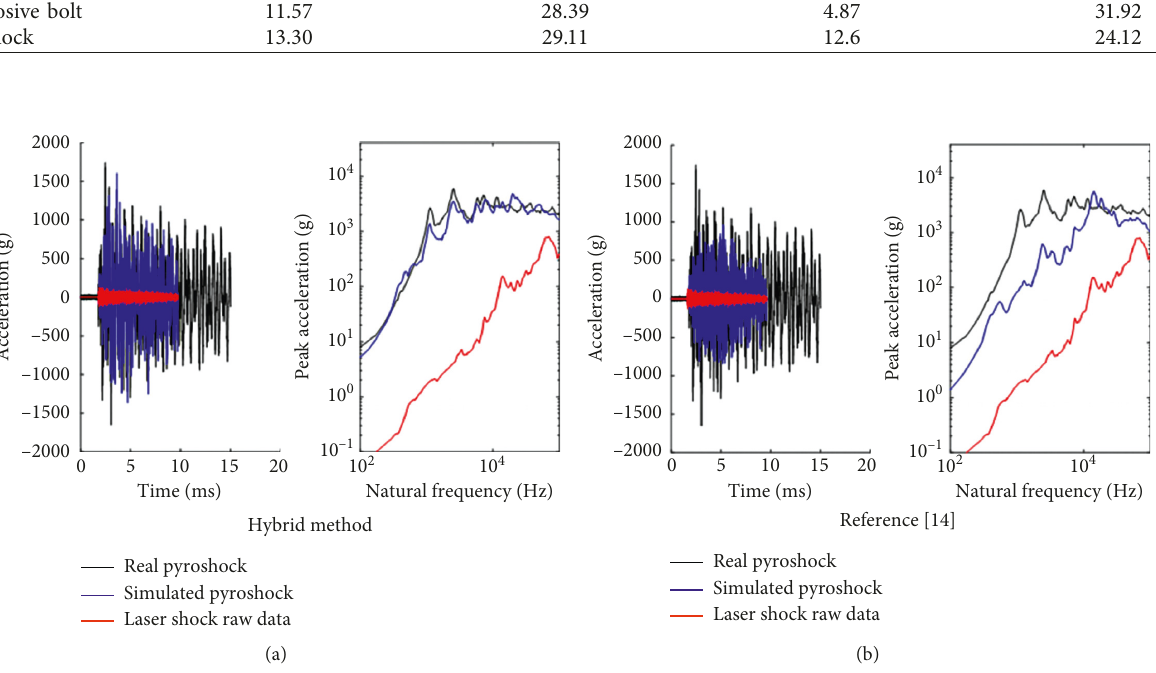
Figure 12: Comparison of the simulation performance between the conventional pyroshock simulation algorithm and the developed algorithm at the verification point: (a) hybrid method and (b) reference